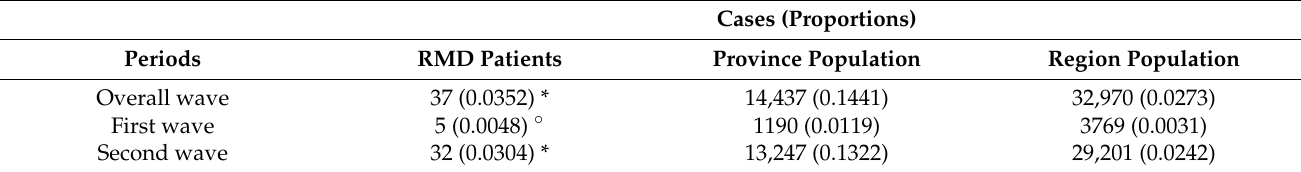
Table 3 reported the characteristics of the patients who tested positive for